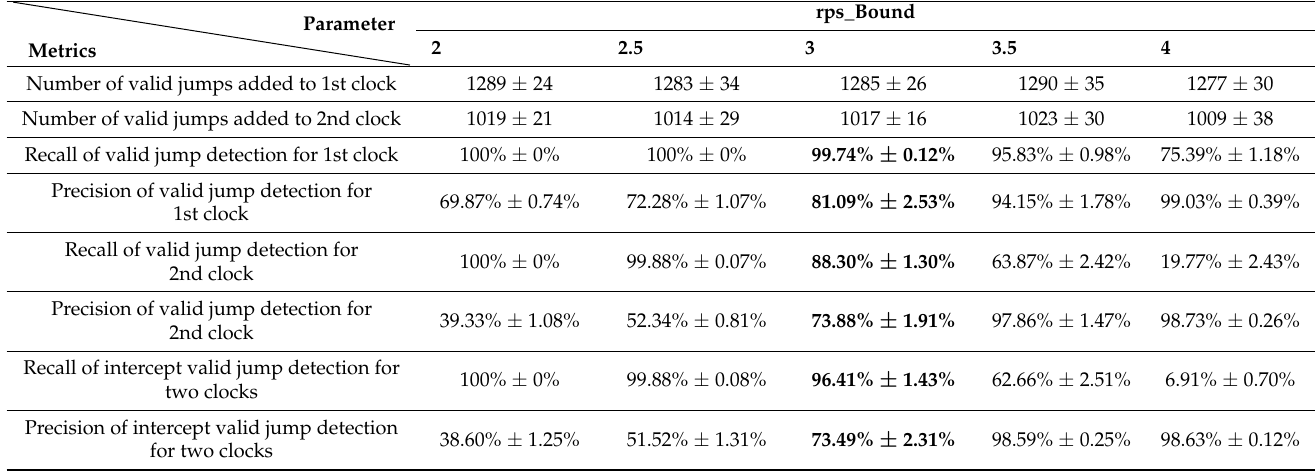
Table 2. Statistical results for the detection of two clocks